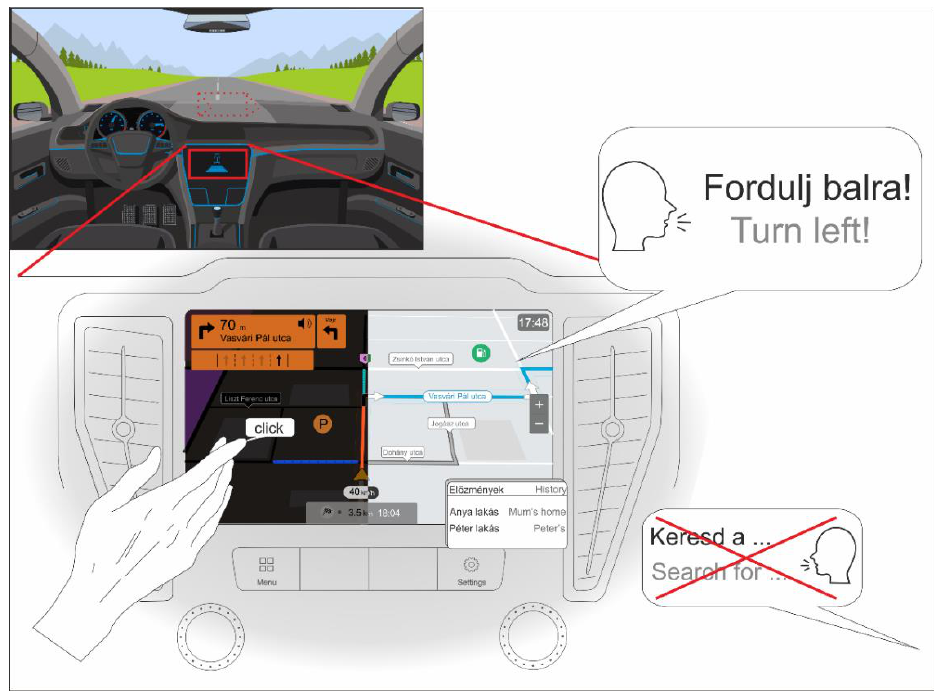
Figure 11. The ideal built-in navigation interface based on 213 answers from three countries.